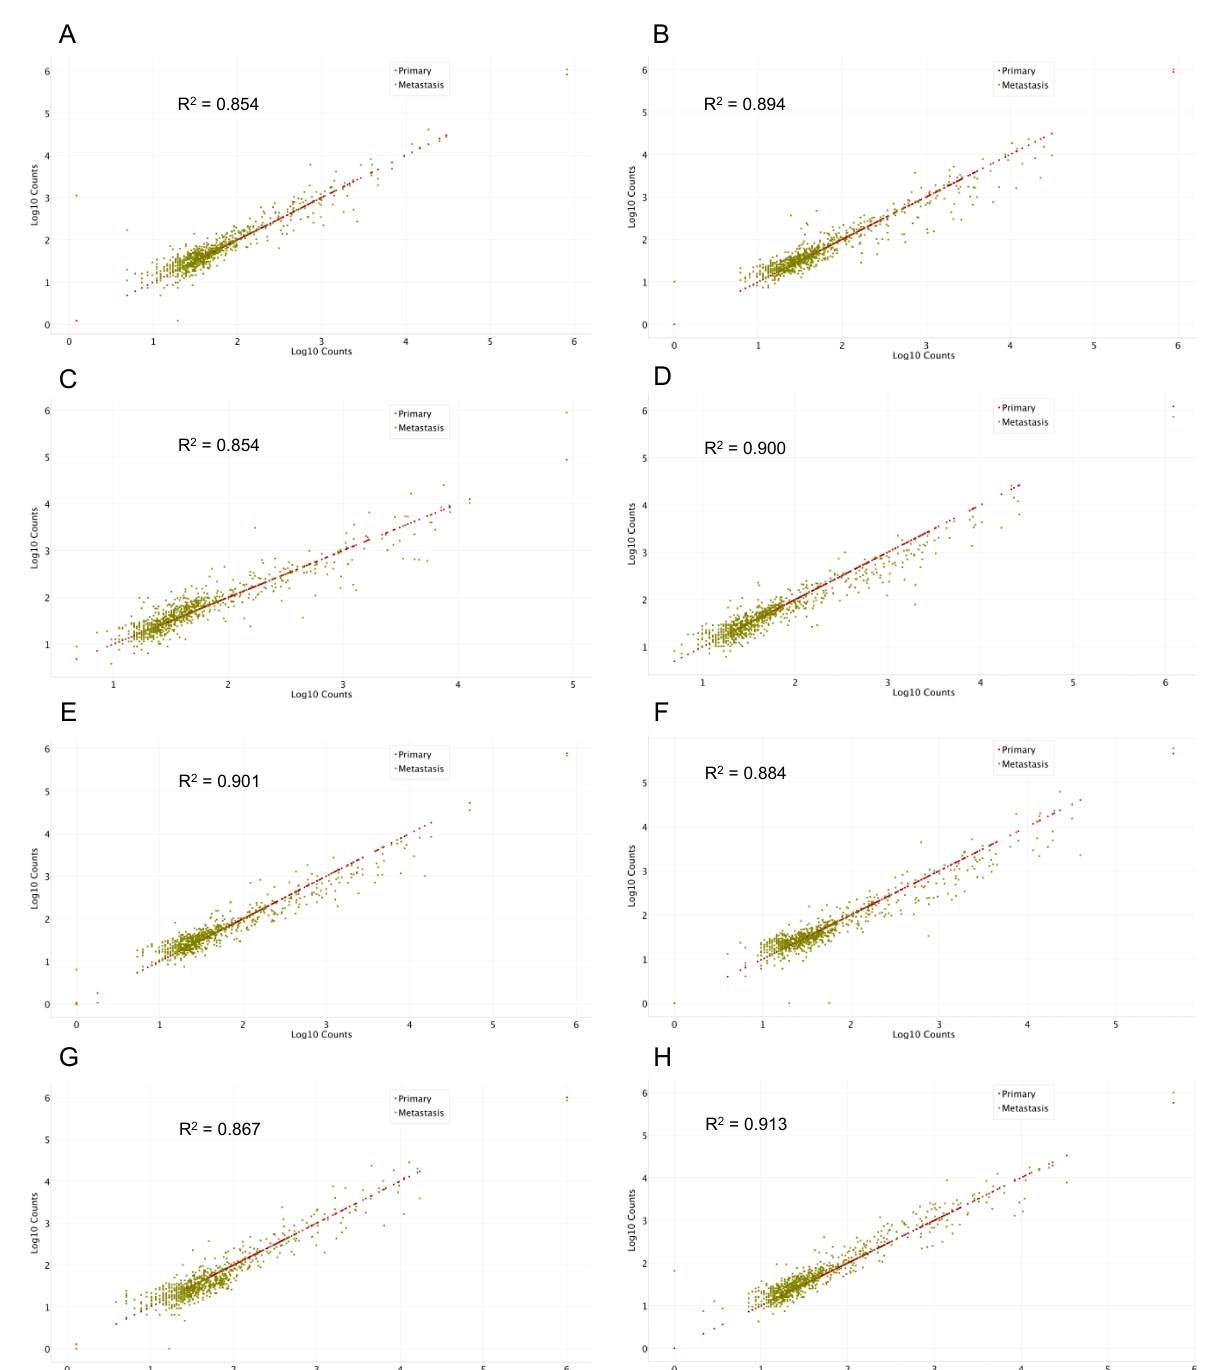
Figure 2. Correlation scatter plot of miRNA expression (log 10 counts) in primary NSCLC versus brain metastasis. ( A – H ) Individual examples of global miRNA expression (log 10 counts) in paired primary versus brain metastatic NSCLC. Each dot represents one miRNA. miRNAs in primary NSCLC are plotted on a linear line with identical expression on the x - and y -axis. miRNAs in brain metastasis are plotted either above or below the corresponding miRNA in primary NSCLC with expression indicated on the y -axis. Red = miRNA expression in primary NSCLC; green = miRNA expression in metastatic lesions. R-squared values of least squares regression are indicated in all panels for miRNAs expressed in metastatic